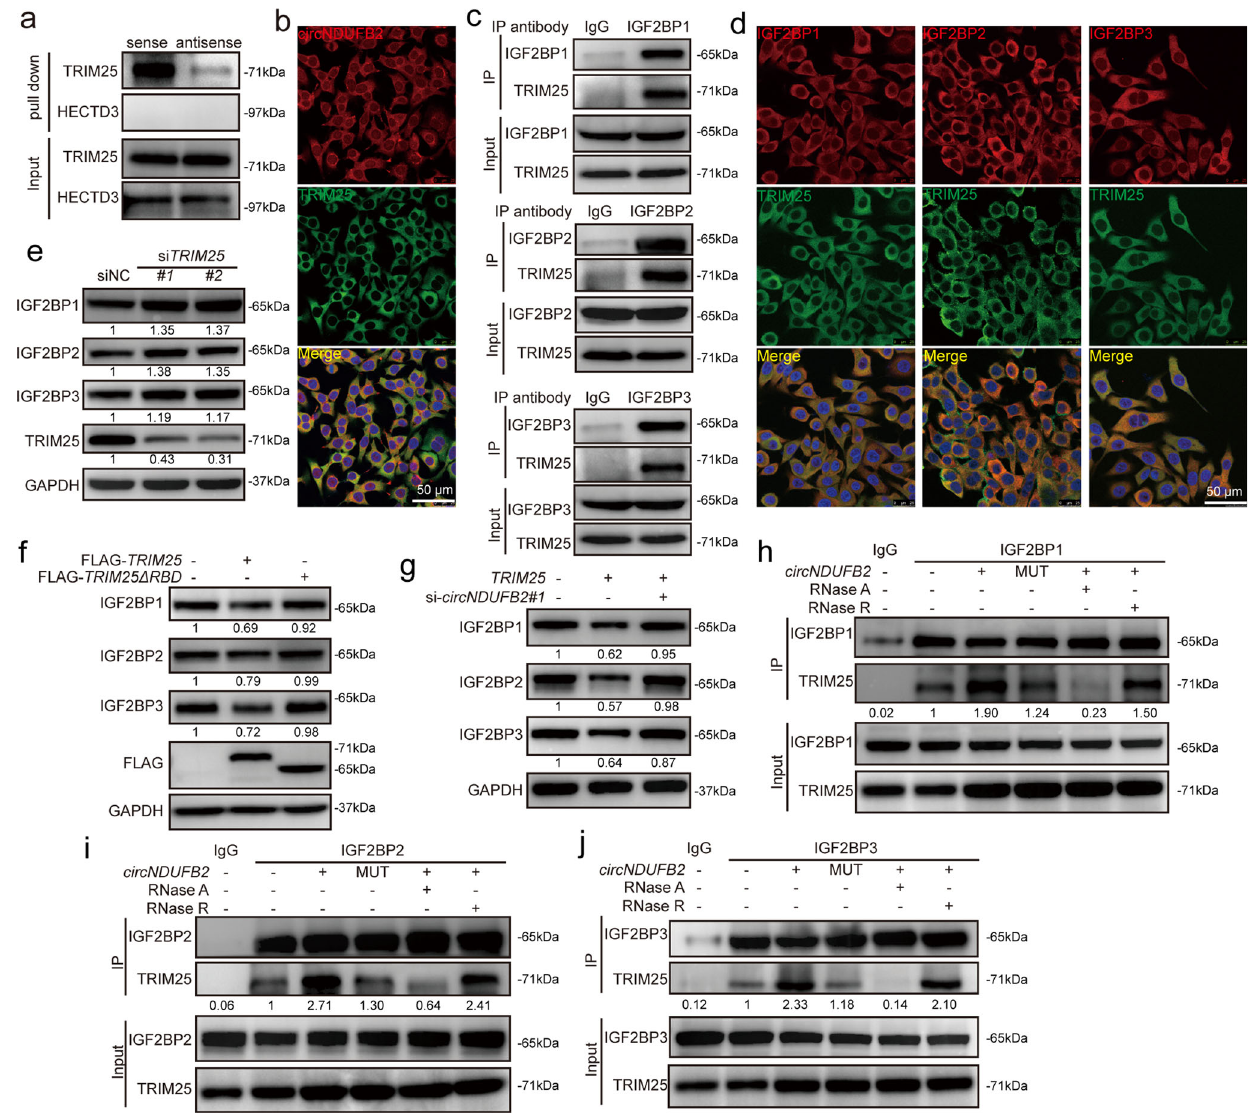
Fig. 4 circNDUFB2 acts as a scaffold to enhance the binding of IGF2BP proteins with TRIM25. a Binding of circNDUFB2 with TRIM25 or HECTD3 in A549 cells. b RNA FISH-immuno fl uorescence showed the co-localization of circNDUFB2 (red) with TRIM25 (green) in A549 cells. Scale bar = 50 μ m. c Co- immunoprecipitation (Co-IP) showed the binding of TRIM25 with IGF2BPs in A549 cells. d Immuno fl uorescence detected the co-localization of IGF2BPs (red) with TRIM25 (green) in A549 cells. Scale bar = 50 μ m. e Protein levels of IGF2BPs in A549 cells with TRIM25 knockdown. f Protein levels of IGF2BPs in A549 cells with TRIM25 or TRIM25-mutant (TRIM25 Δ RBD) overexpression. g After TRIM25 overexpression, immunoblot detected protein levels